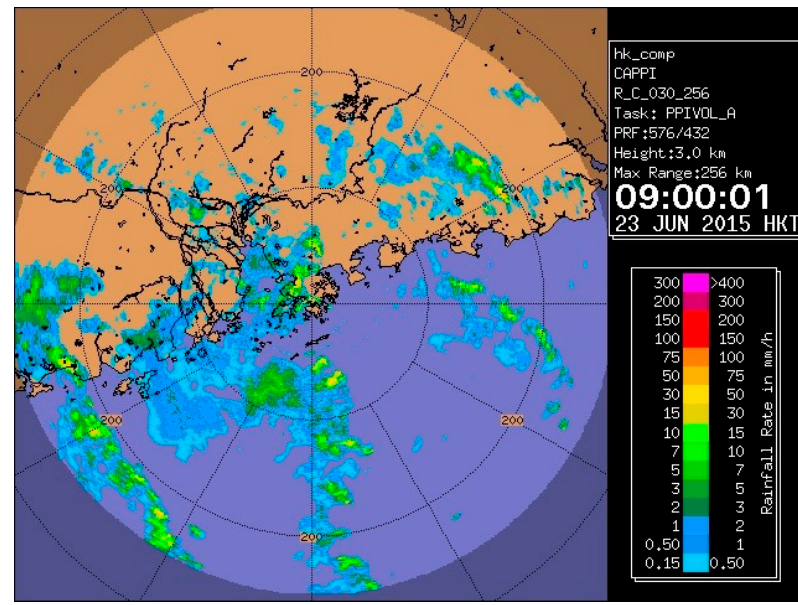
Figure 15. ( a , b ) The predicted 500 hPa moisture (RH shaded) and wind fields (streamlines) of ( a ) ECMWF, ( b ) JMA for 23 June 2015 00 Z. ( c ) Ground truth of the same time based on ECMWF anal- ysis field.